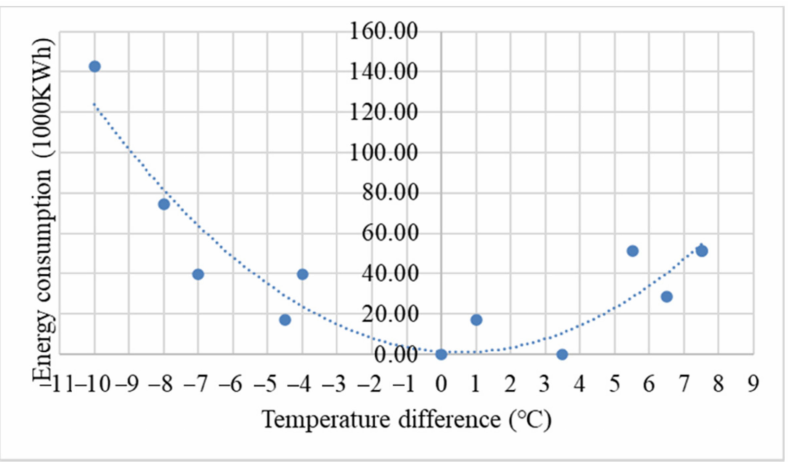
Figure 5. Energy consumption of HVAC under various